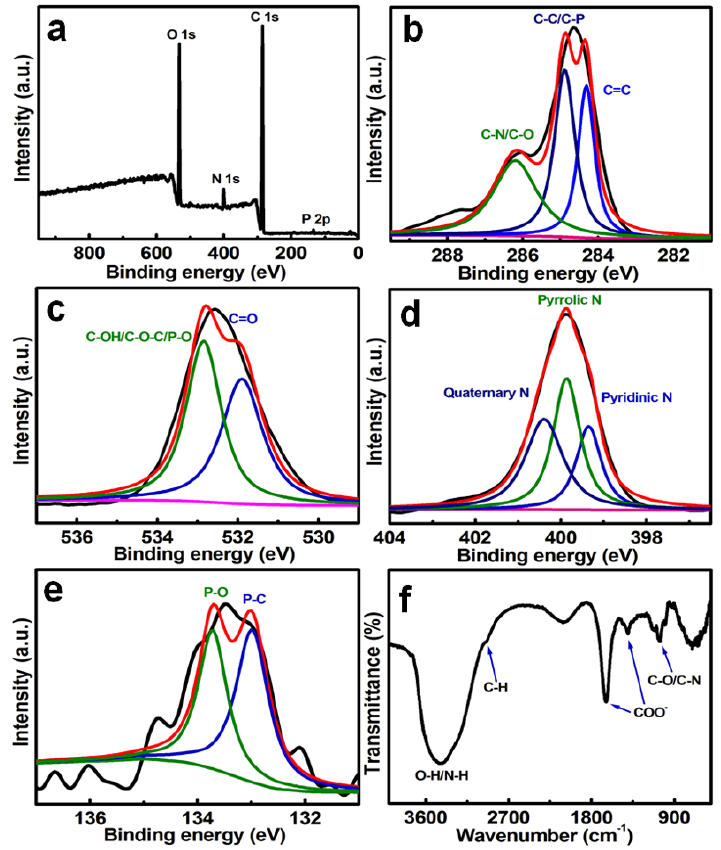
Figure 1. ( a – e ) XPS spectra and corresponding fitting profiles ( a ) survey spectrum; ( b ) C 1s; ( c ) O 1s; ( d ) N 1s; ( e ) P 2p; and ( f ) FT-IR spectrum for the CQDs-120.